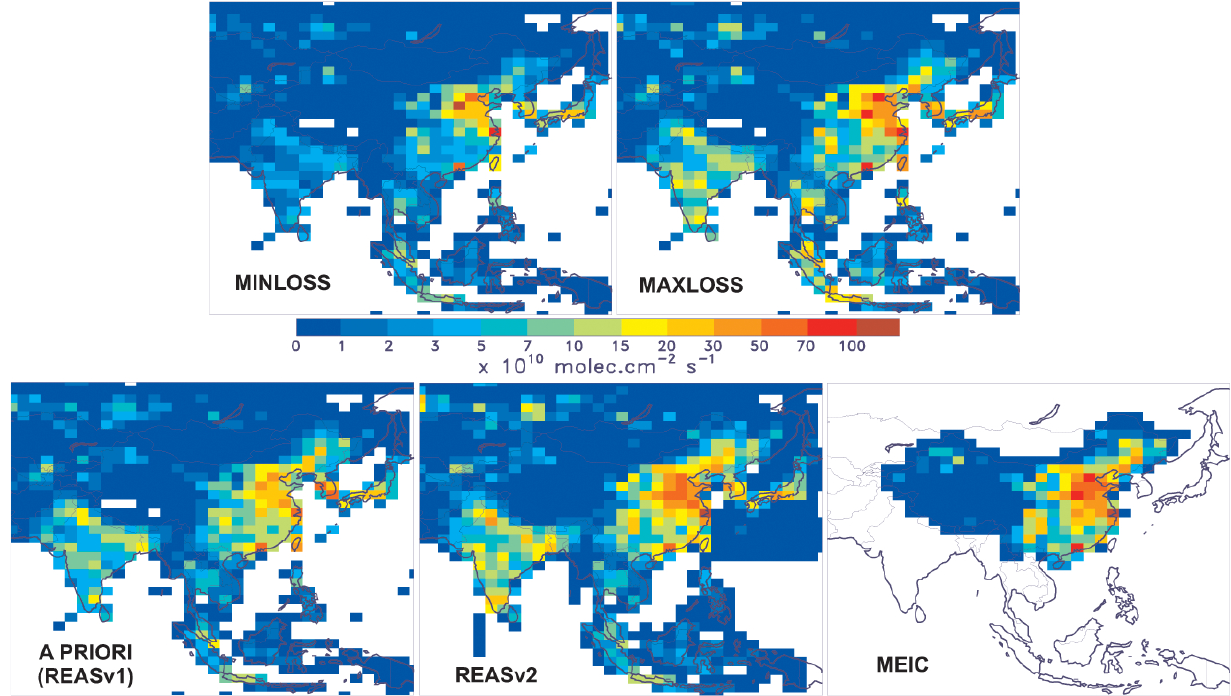
Fig. 13. Comparison between annual anthropogenic emissions inferred from MINLOSS and MAXLOSS inversions (upper panels), and a priori emissions from REASv1, REASv2, and emissions from Multi-Resolution Emission Inventory in China (MEIC) in